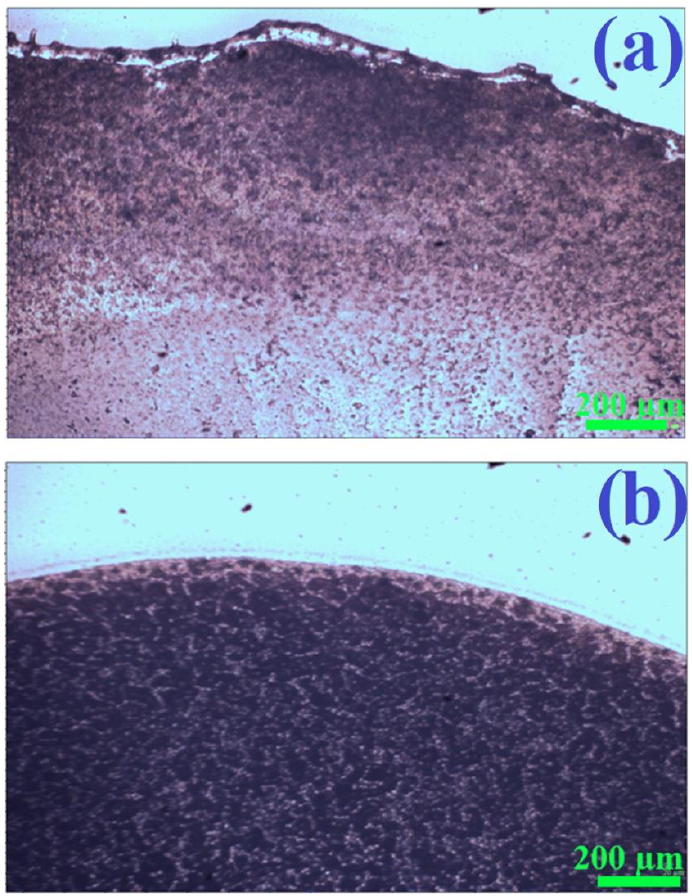
Figure 6. Photographs of fragments of films of (Fe 3 O 4 @Ag)@SiO 2 nanoparticles on a glass substrate obtained by drying a drop of the sol of (Fe 3 O 4 @Ag)@SiO 2 nanoparticles: ( a ) without applying a strong external magnetic field, and ( b ) when the sample was placed in a strong external magnetic field. For the photographs presented, brightness correction was performed automatically — the physical sense is related only to the differences in the brightness of different areas of the photo. Images obtained using an Olympus BX40 microscope with a 4× objective.